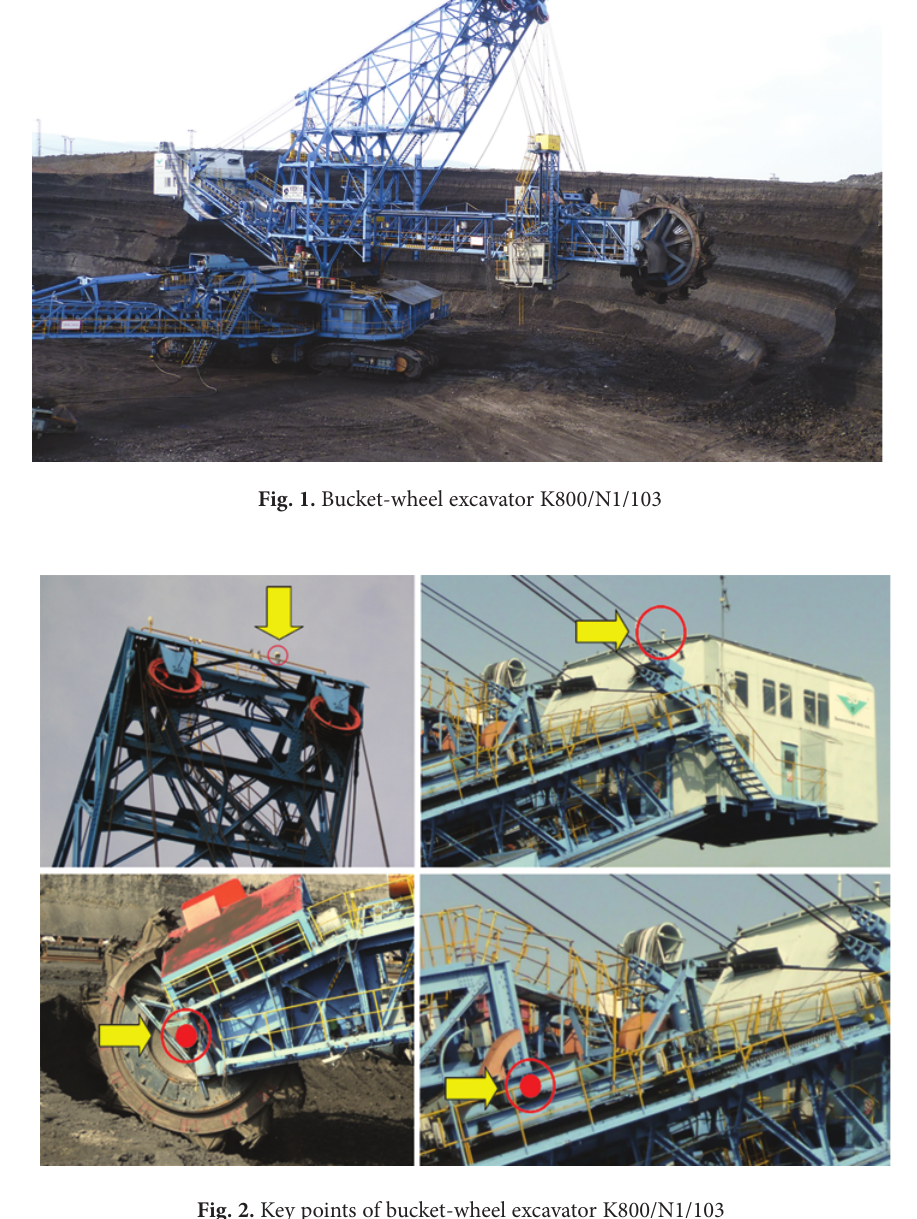
Fig. 2. Key points of bucket-wheel excavator